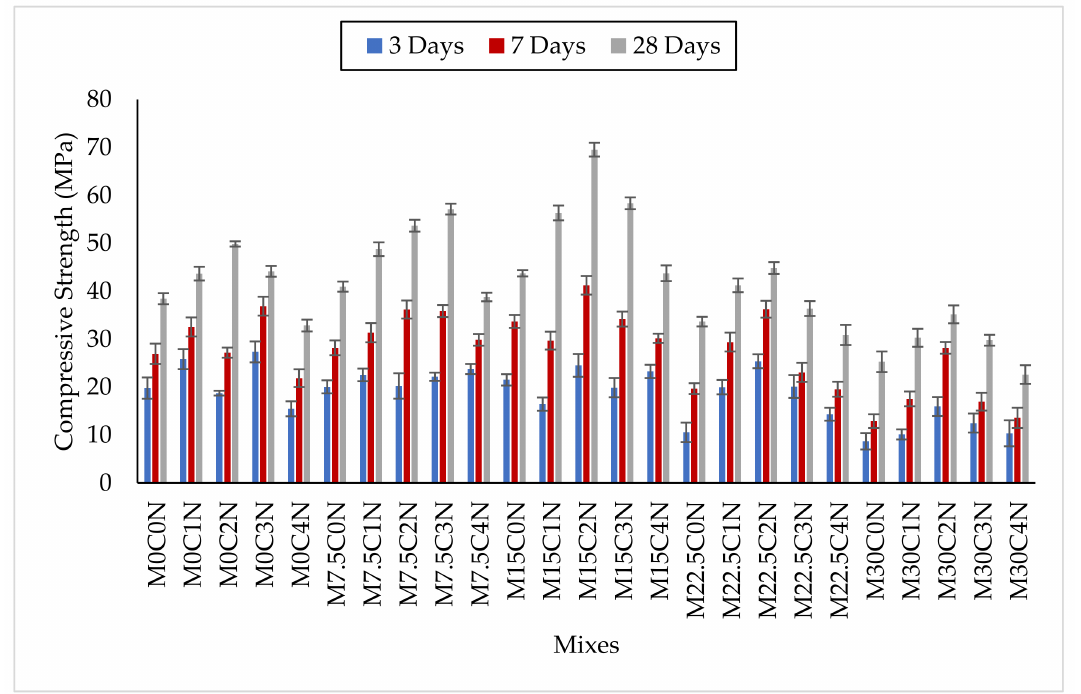
Figure 7. Compressive Strength